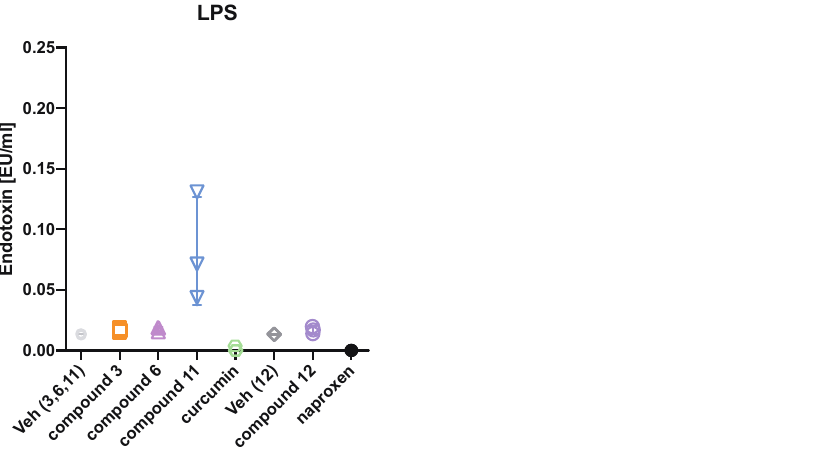
Figure 4. Summary of the endotoxin level evaluation in the highest non-cytotoxic concentration of selected compounds. Veh ( 3 , 6 , and 11 )—solvent for compounds 3 , 6 , and 11 , and CUR; veh ( 12 )—solvent for compound 12 and naproxen, n = 3.